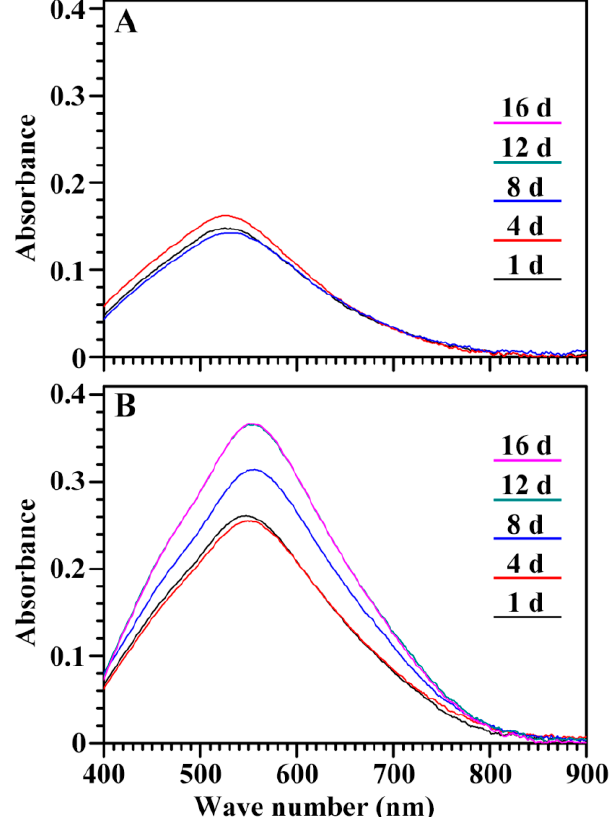
Figure 10. The iodine absorption spectrum of endosperm starch during seedling growth. ( A ) GLXN, ( B ) GTR. Table 1. The iodine absorption parameters of starch isolated from the endosperm during seedling growth a .